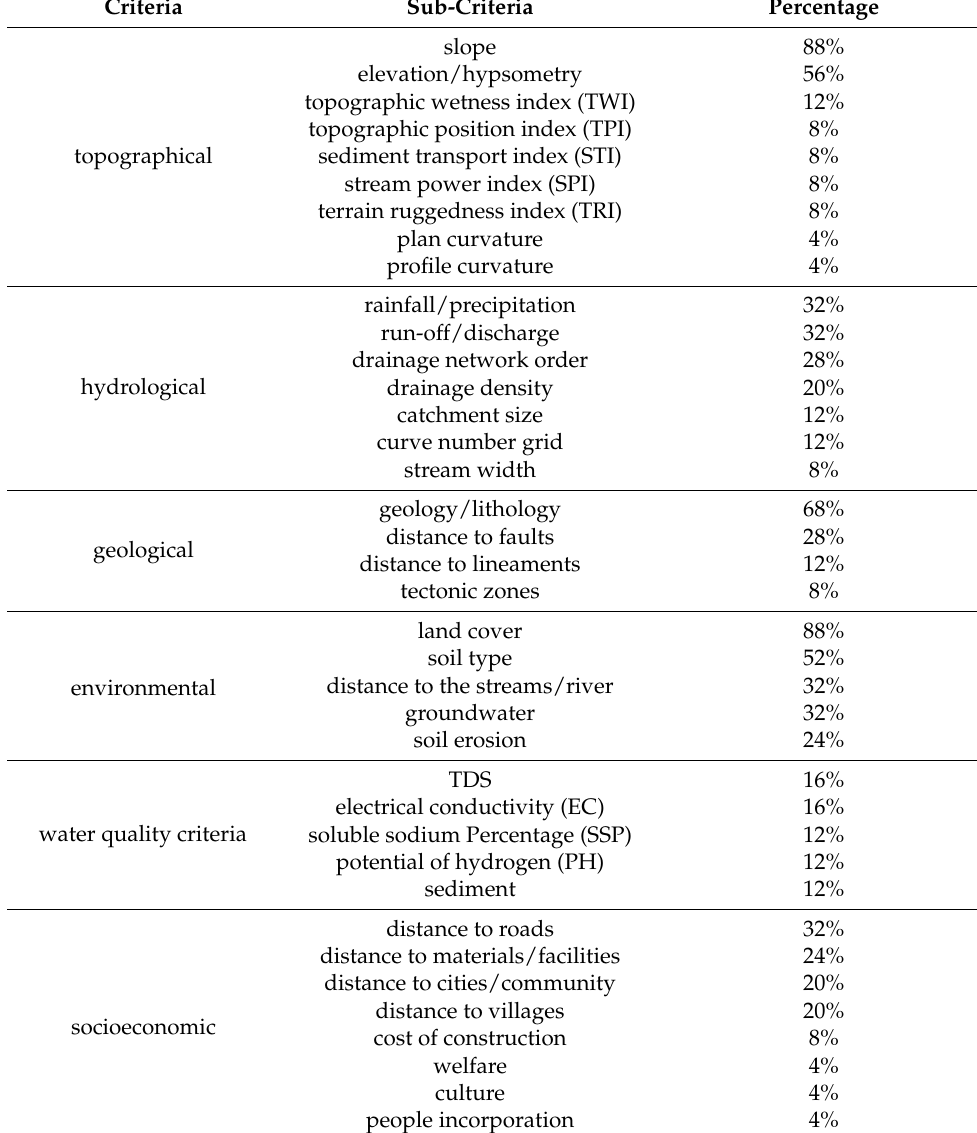
Table 4. A Listing of site selection impact